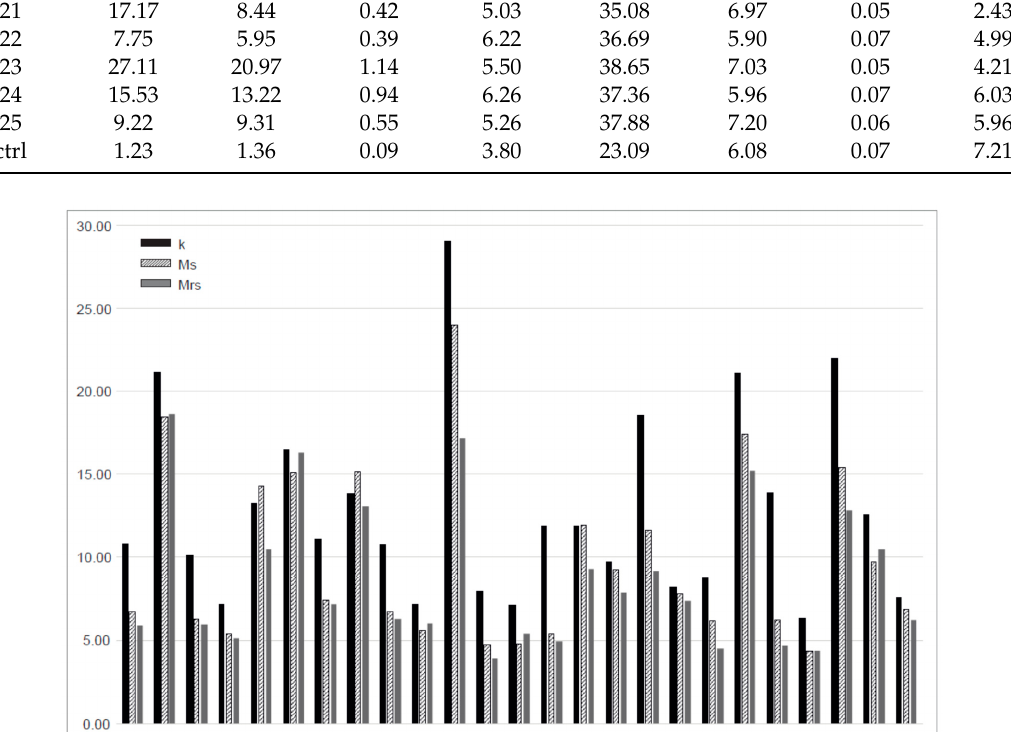
Figure 2. Histograms of the concentration-dependent magnetic parameters, normalized to the control sample; black columns for magnetic susceptibility (k), dithered for Ms, grey for Mrs.